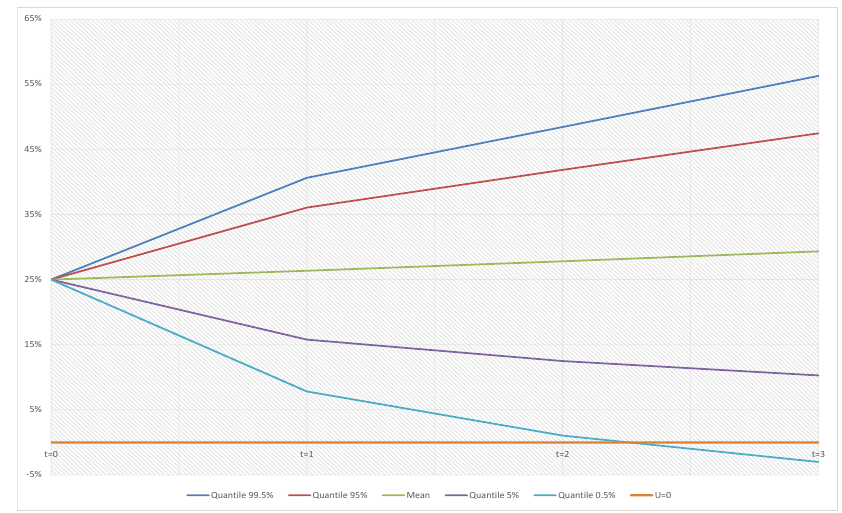
Figure 12. ˜ u t , for t = 0, 1, 2, and 3 Net of Quota Share (QS) Reinsurance-Baseline portfolio mix ( u 0 = 25%).